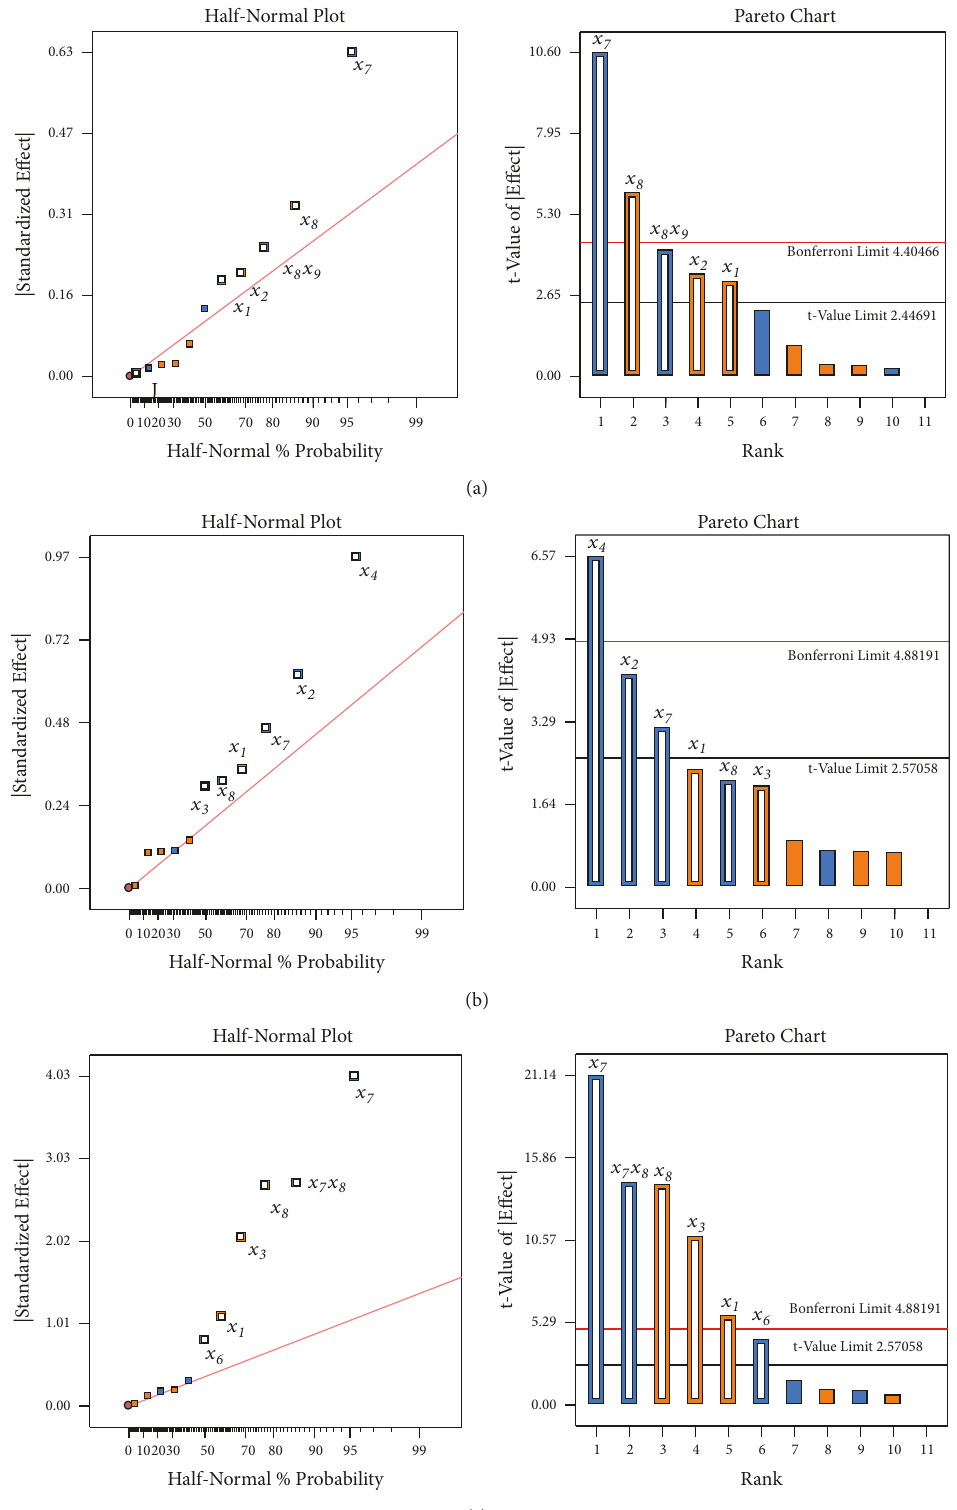
Figure 1: Half-normal plot and Pareto chart showing the significant effects based on the observation of Plackett–Burman design for the investigated responses (a) Rs between impurity E and F ( 𝑦 1 ); (b) Rs between SIM and impurity G ( 𝑦 2 ); (c) Rs between impurity B and C ( 𝑦 3 ) where 𝑥 1 is molarity of ammonium formate (mM); 𝑥 2 is flow rate (mL/min); 𝑥 3 is wavelength (nm); 𝑥 4 is volume of injection ( 𝜇 L); 𝑥 5 is detector acquisition rate (Hz); 𝑥 6 is column temperature ( ∘ C); 𝑥 7 is percent of organic modifier in the initial mobile phase composition (%); ∘ C). Positive effects are marked with white bar box 𝑥 𝑥 8 is column of the same composition but of different lot; and 9 is injector temperature ( with orange frame and orange bar box for significant and insignificant factor, respectable. Negative effects are marked with white bar box with blue frame and blue bar box for significant and insignificant,